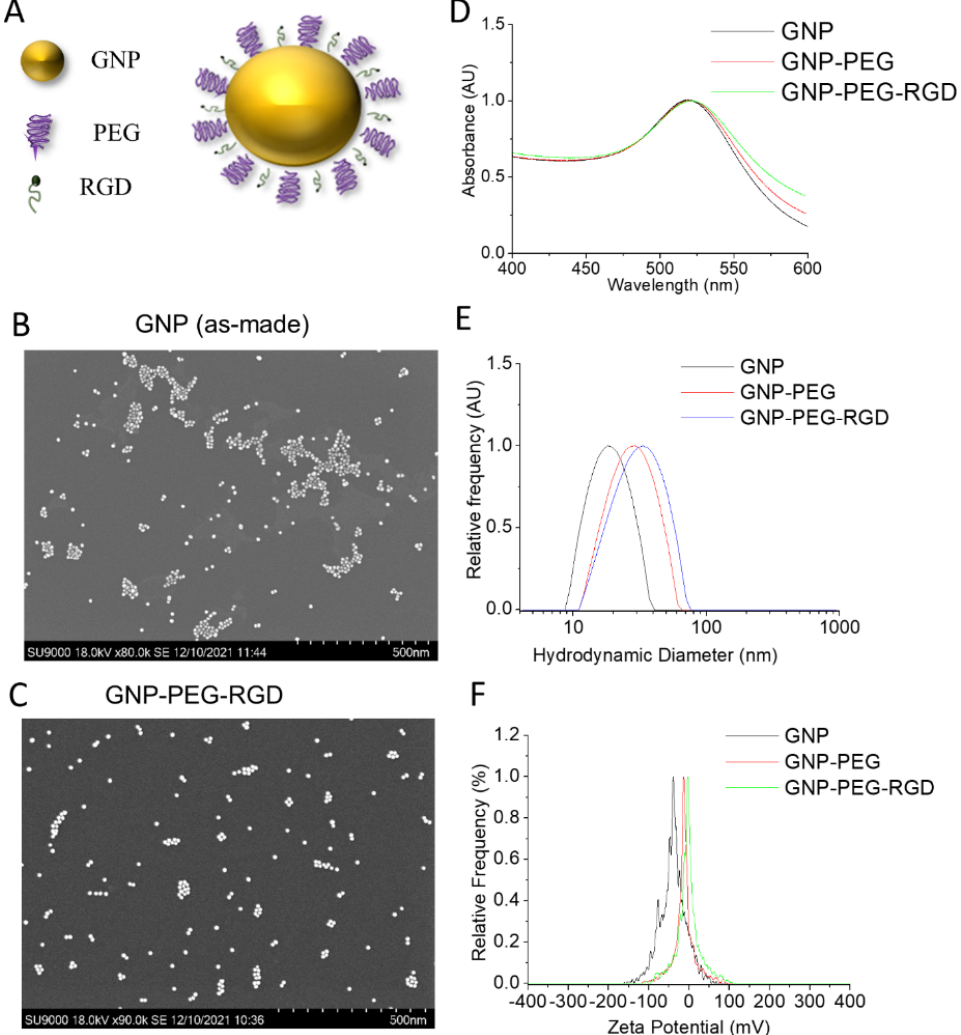
Figure 2. Characterization of the gold nanoparticles (GNPs). ( A ) Schematic showing GNP with measured core diameter of~13.2 functionalized with a polyethylene glycol (PEG) molecule as stabilizing agents, and RGD peptides to improve GNPs uptake. ( B , C ) Transmission Electron Microscopy (TEM) Image of as made GNP and GNP PEG-RGD . ( D – F ) UV-visible absorption spectra, hydrodynamic diameter, and ζ -potential measurements of pure GNPs, GNP PEG , and GNP PEG-RGD , respectively. Three different ratios of CAF98 to MIA PaCa-2 were chosen to represent heterogeneity in TME. After GNP incubation, cell populations were isolated for quantifying GNP